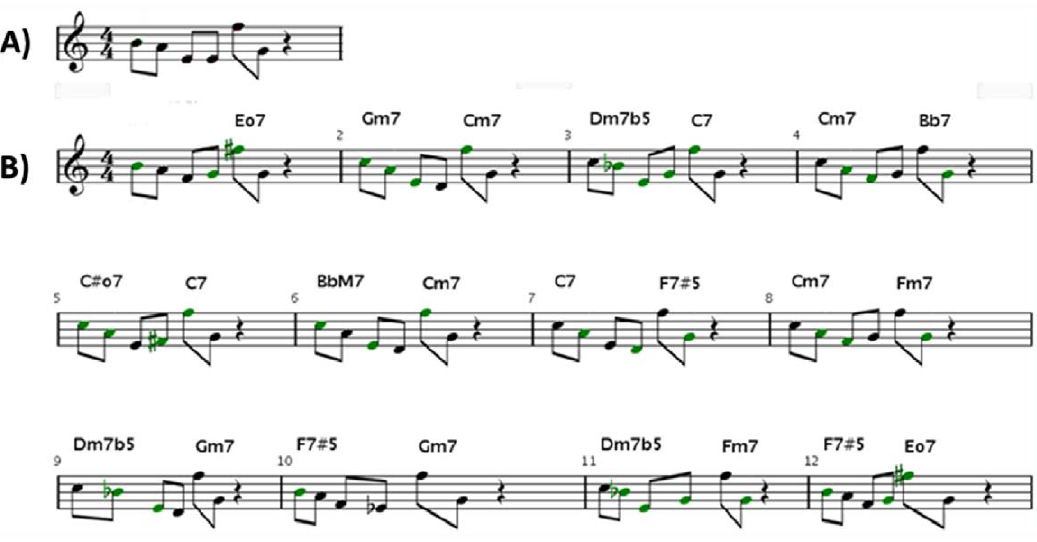
Figure 2. Microbial Bebop highlights relationships between data. In this example, the notes in measure in (A) are comprised of six hypothetical data points. All twelve measures in (B) are derived from the same six data points, but each measure is rectified to different chords, representing the same data played in context of different hypothetical parameters. Each measure in (B) is subtly but audibly distinct, demonstrating ability of Microbial Bebop to represent data in a way that can potentially be interpreted by a listener. An audible version of (B) is available (www.bio. anl.gov/MicrobialBebop.htm).